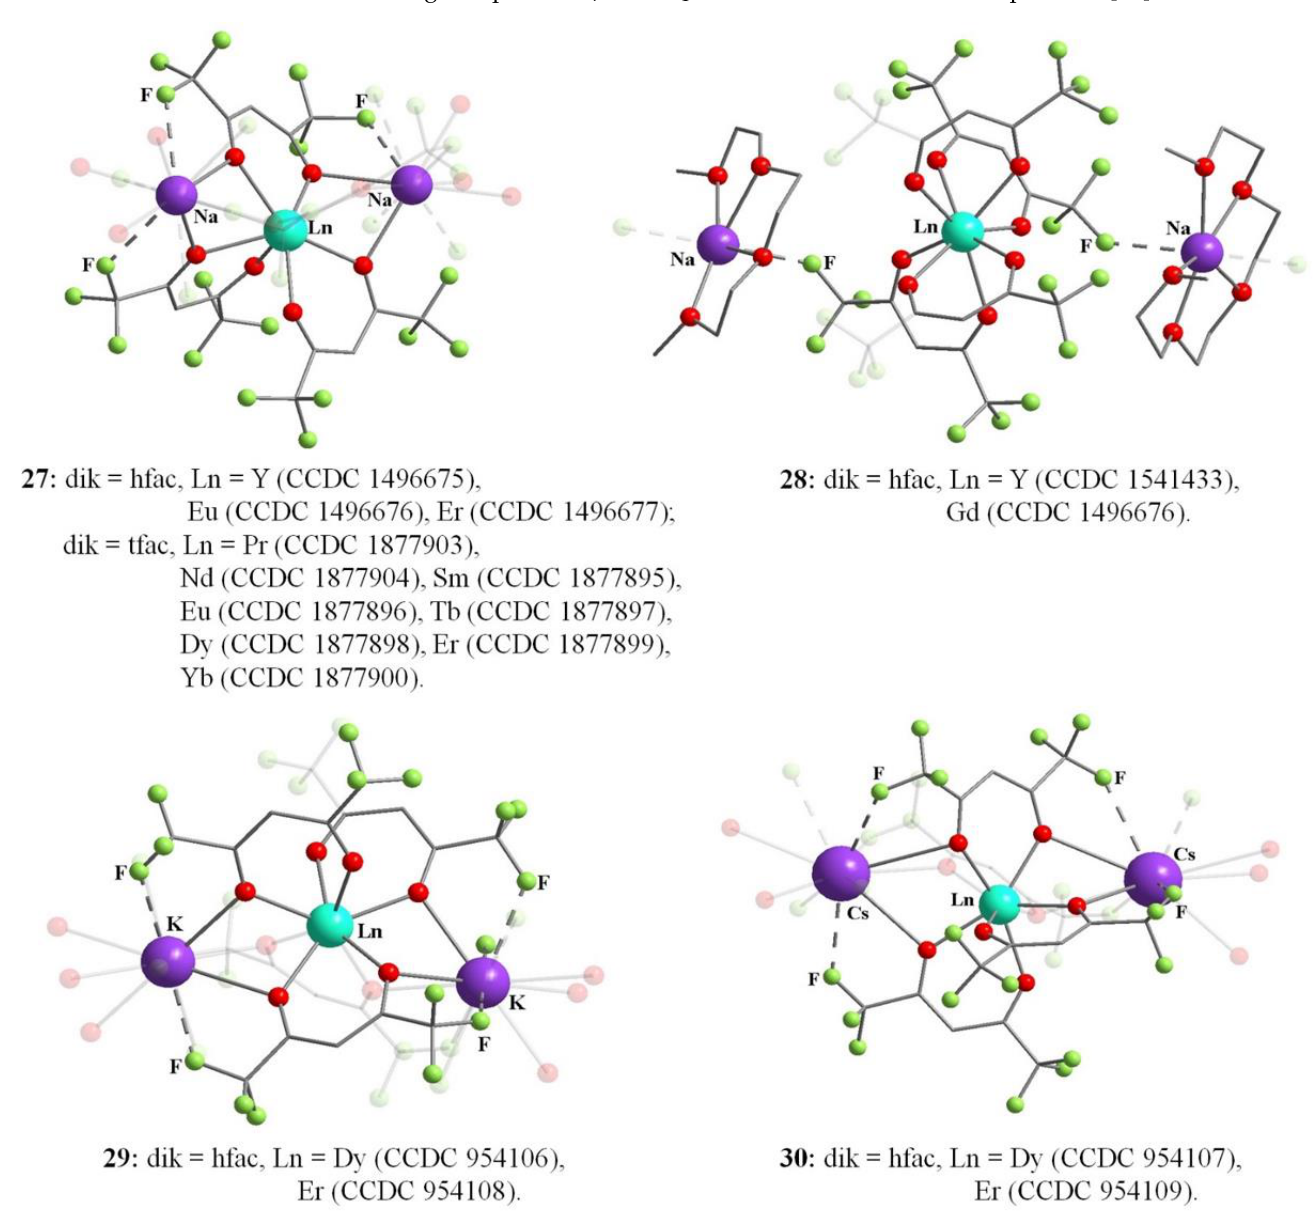
Figure 13. Molecular structures of Ln(III) tetrakis -diketonates 27 – 30 [78–81]. Hydrogen atoms and some CF 3 groups have been omitted for clarity. The cifs has been retrieved from CCDC.